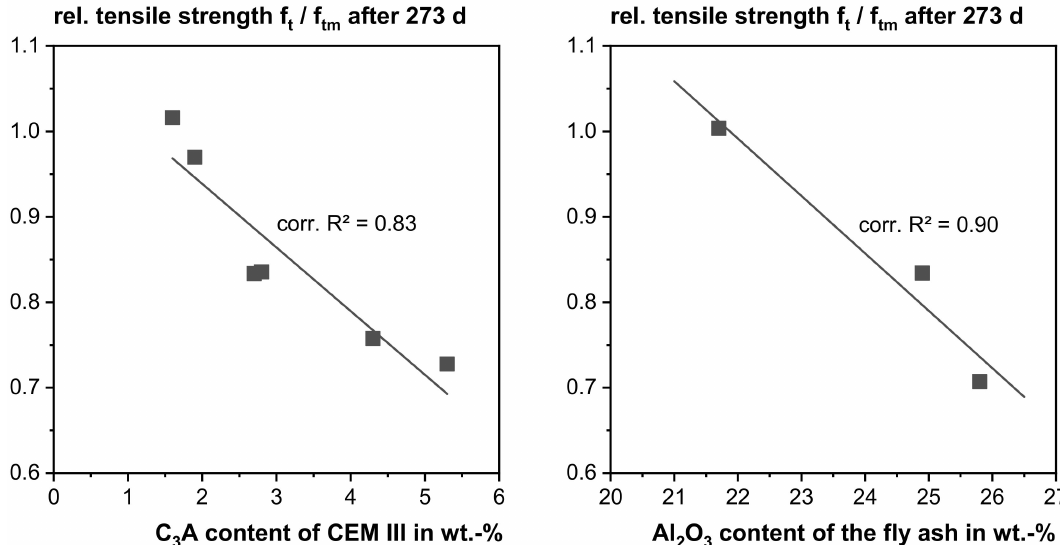
Figure 8. Relative tensile strength after 273 d storage in 6000 mg SO 42 − /L at 5 ◦ C over the C 3 A content of blastfurnace slag cement (CEM III) ( left ) and the Al 2 O 3 content of fly ash ( right